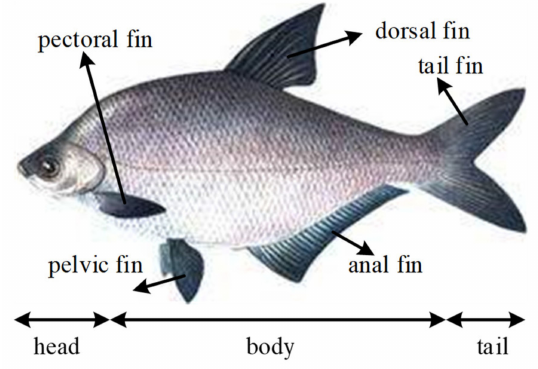
Figure 6. Description of bream body structure and shape.